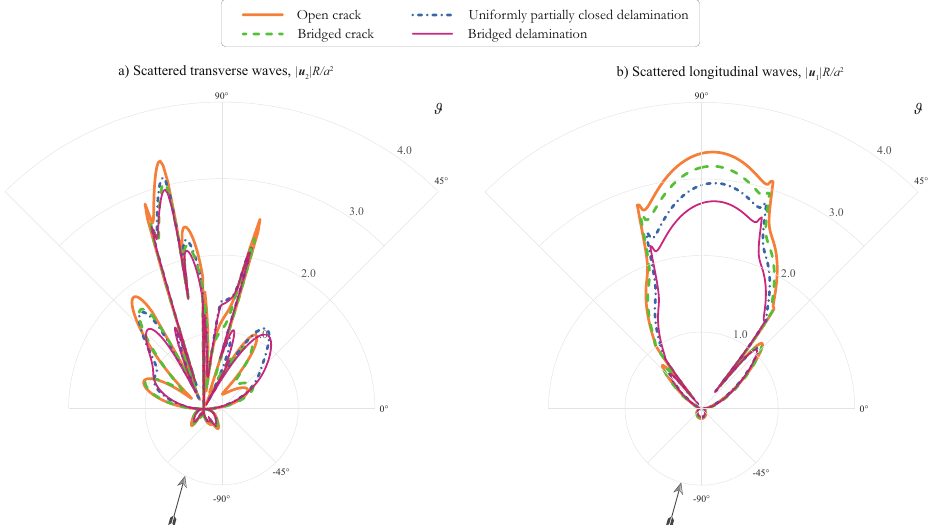
Figure 12. Amplitudes of the transverse | u 2 ( 10 3 , θ = π /2 ± π /2, ϑ ) | ( a ) and longitudinal | u 1 ( 10 3 , θ = π /2 ± π /2, ϑ ) | ( b ) waves scattered by a circular interface delamination for the transverse SV- wave incident at 15 ◦ angle to plane x 3 = 0 and 90 ◦ angle to plane x 2 = 0: two half-spaces are made of aluminium and polycarbonate, k T 2 a =